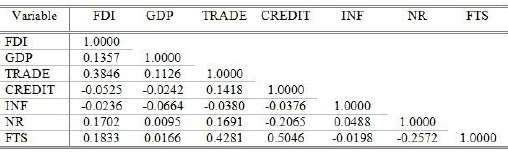
Table 5: Optimal Lag-Length